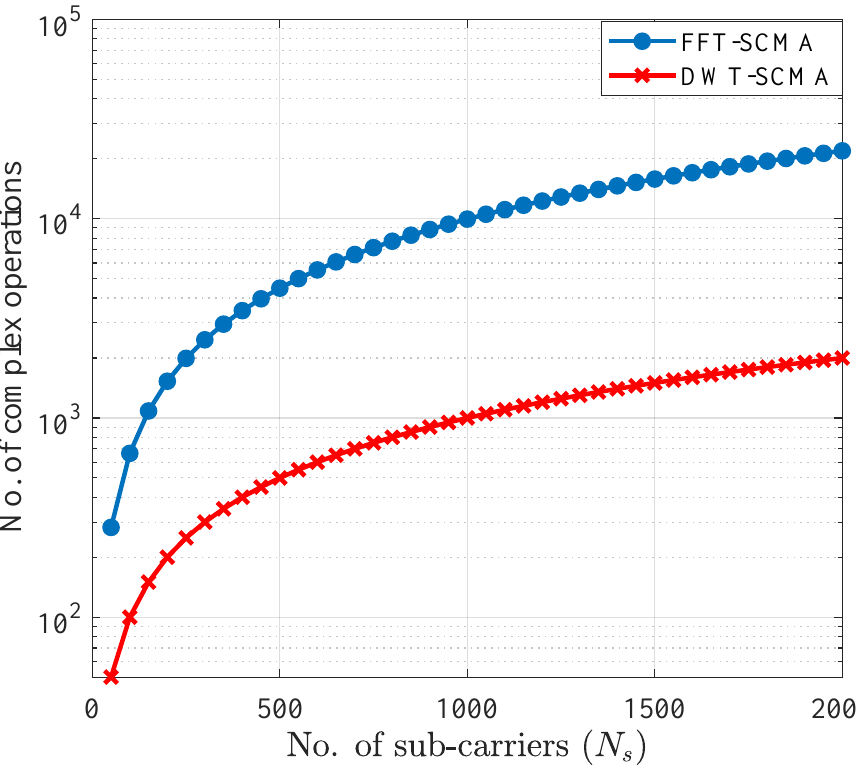
Figure 12. Number of complex operations in FFT-SCMA and